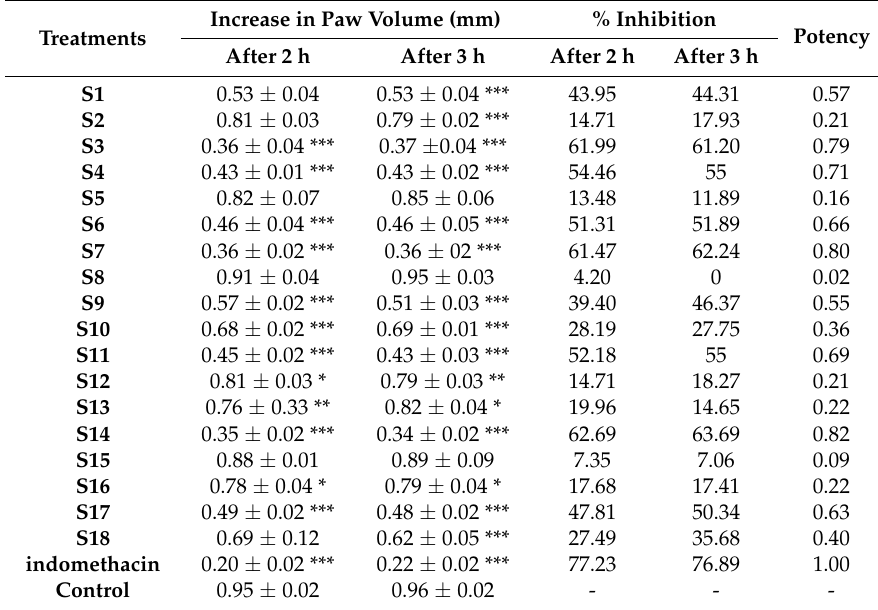
Table 1. Anti-inflammatory activity of compounds ( S1 – S18 ).